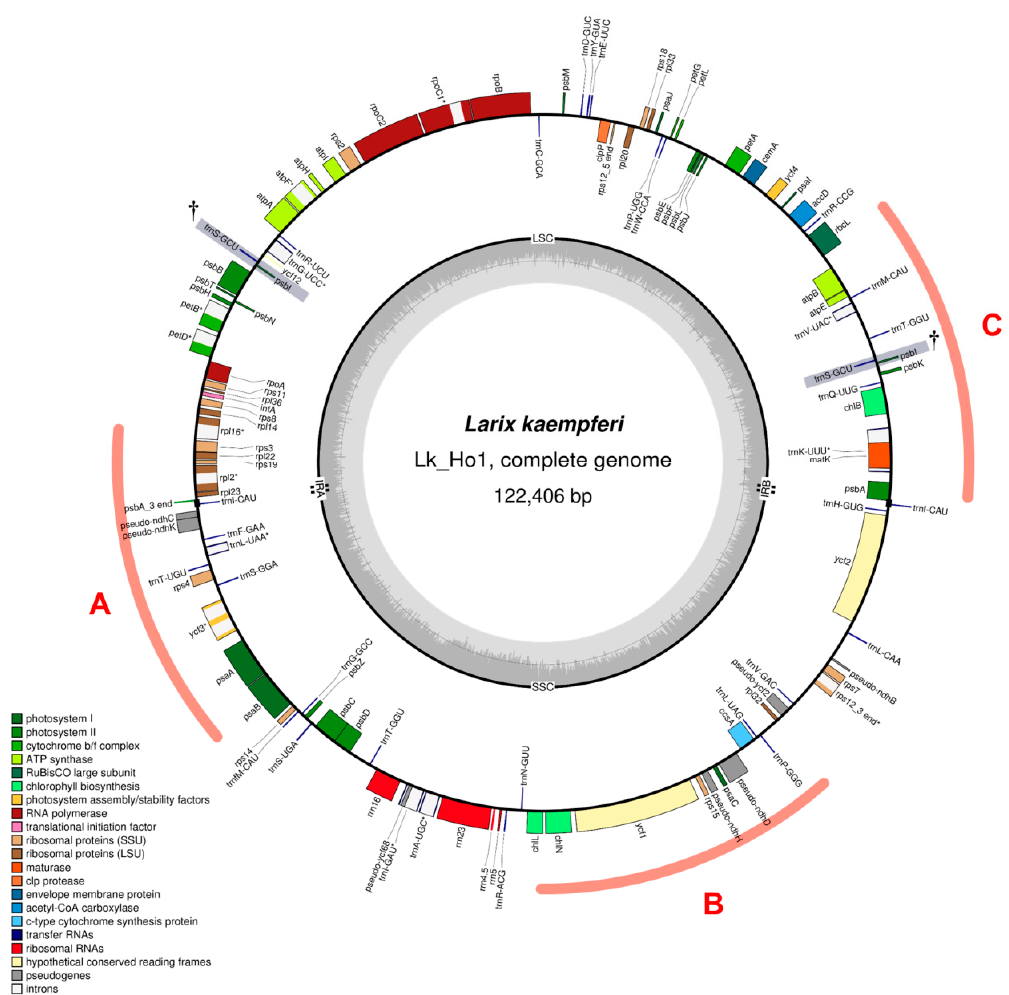
Figure 3. A gene map of Japanese larch chloroplast genome (accession number: LC574969). Genes shown outside and inside the circle are transcribed clockwise, and transcribed counterclockwise, respectively. Genes were colour-coded to distinguish different functional groups. The dark and light gray inner circle indicates the GC and AT content of the chloroplast genome, respectively. “†” represents the location of a longer inverted repeat. A, B and C represent hotspot of variation.